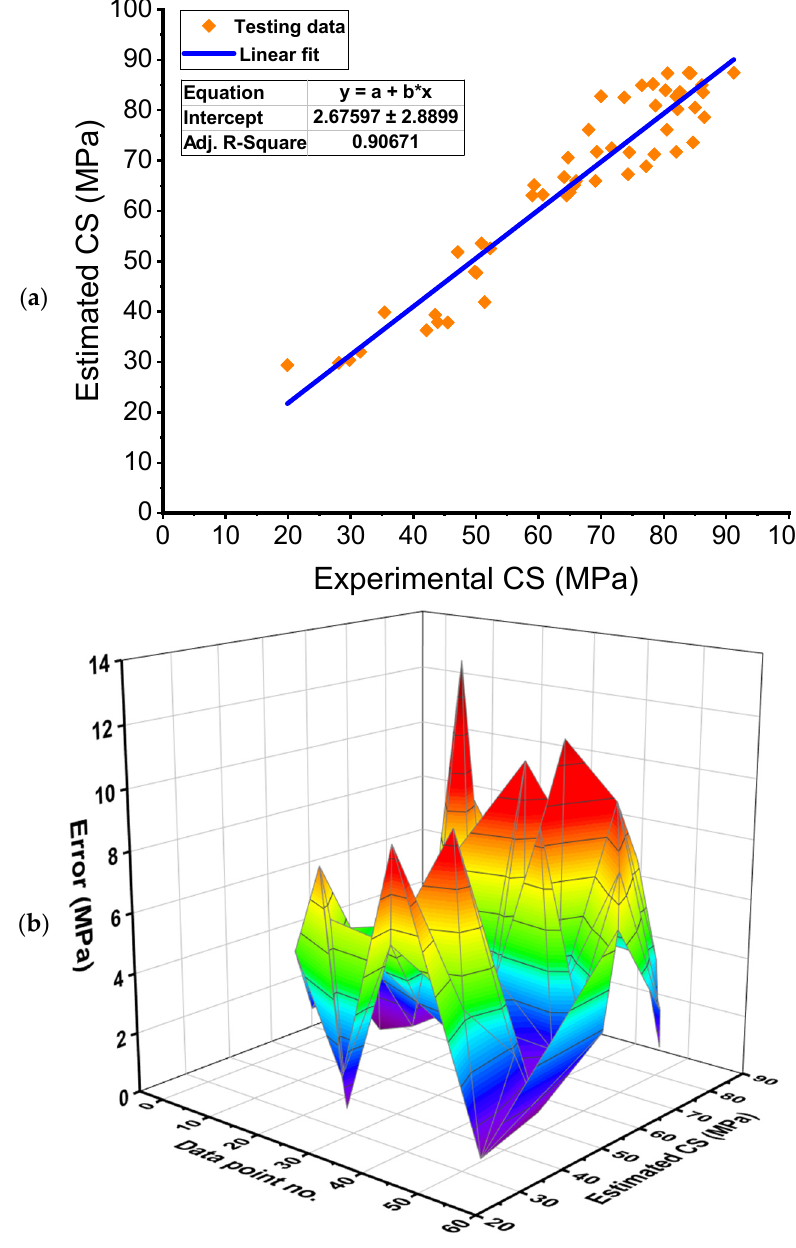
Figure 8. Random forest model: ( a ) Relation between real and anticipated outcomes; ( b ) Dispersion of anticipated results and errors. 𝐸𝑟𝑟𝑜𝑟 = |𝐸𝑥𝑝𝑒𝑟𝑖𝑚𝑒𝑛𝑡𝑎𝑙 𝑟𝑒𝑠𝑢𝑙𝑡 − 𝐸𝑠𝑡𝑖𝑚𝑎𝑡𝑒𝑑 𝑟𝑒𝑠𝑢𝑙𝑡| .